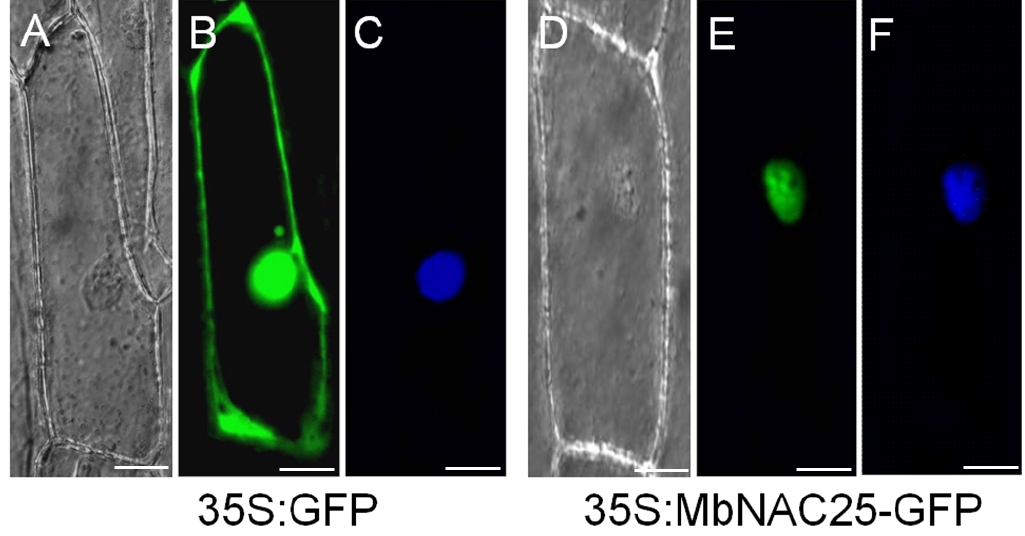
Figure 2. Subcellular localization of MbNAC25 protein. The 35S-GFP and 35S-MbNAC25-GFP translational products were expressed in onion epidermal cells and visualized by fluorescence microscopy in bright light ( A , D ); in dark field for GFP ( B , E ) and DAPI staining images ( C , F ). Scale bar corresponds to 5 μ m.